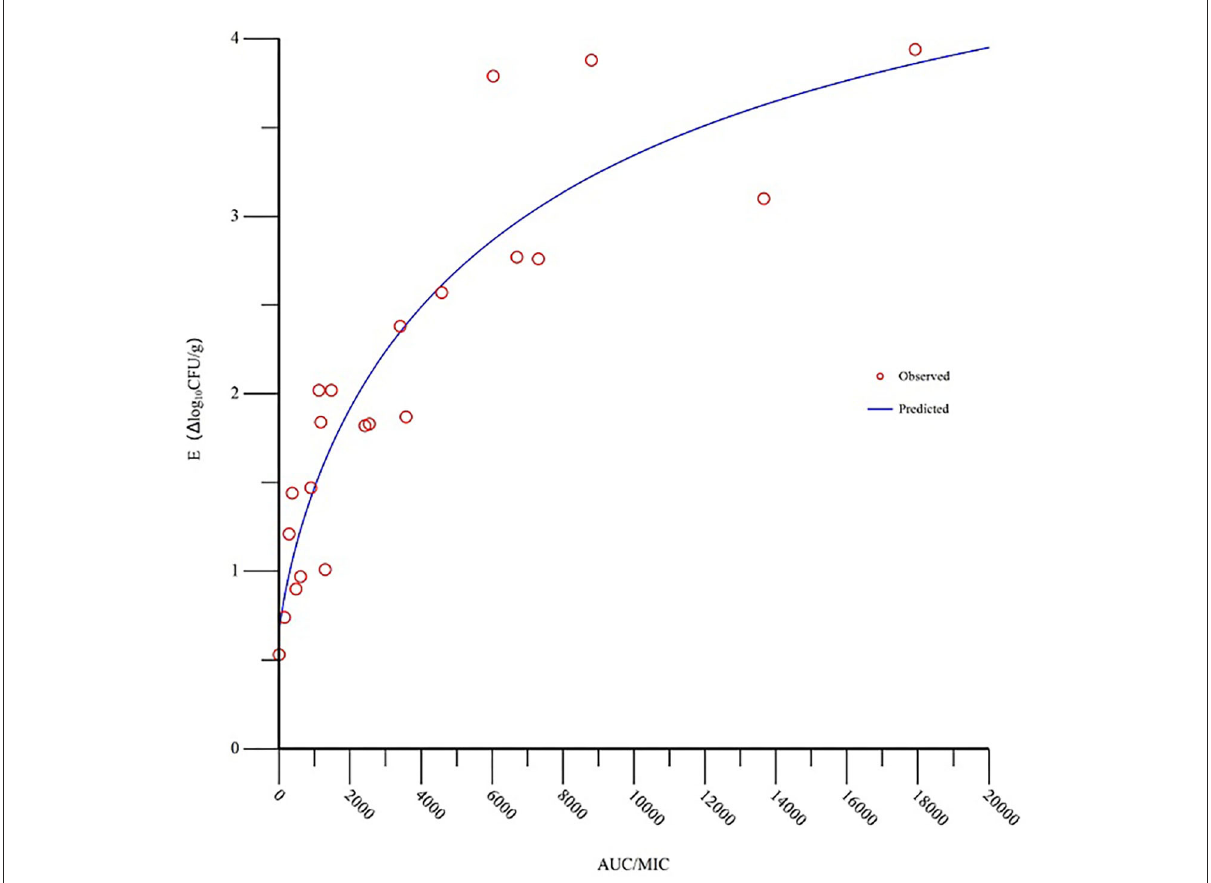
FIGURE5 Sigmoid E max relationships for the anti-mycoplasmal effect (E, log 10 CFU/lung) and the in vivo AUC/MIC (the area under the concentration-time curve divided by the minimal inhibitory concentration) ratio against M. gallisepticum in the lung tissues of